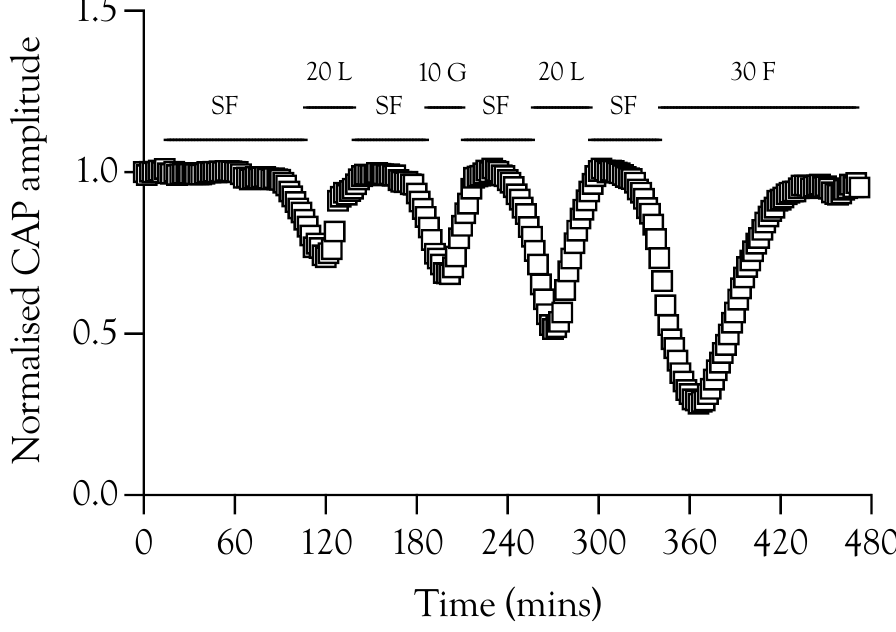
Figure 5. The ability of substrates to recover failing A fibre CAP. A sciatic nerve was repeatedly exposed to substrate-free aCSF (SF) in order to promote CAP failure. The CAP was fully restored on introduction of aCSF containing 10 mM glucose (10 G), 20 mM lactate (20 L), or 30 mM fructose (30 F).